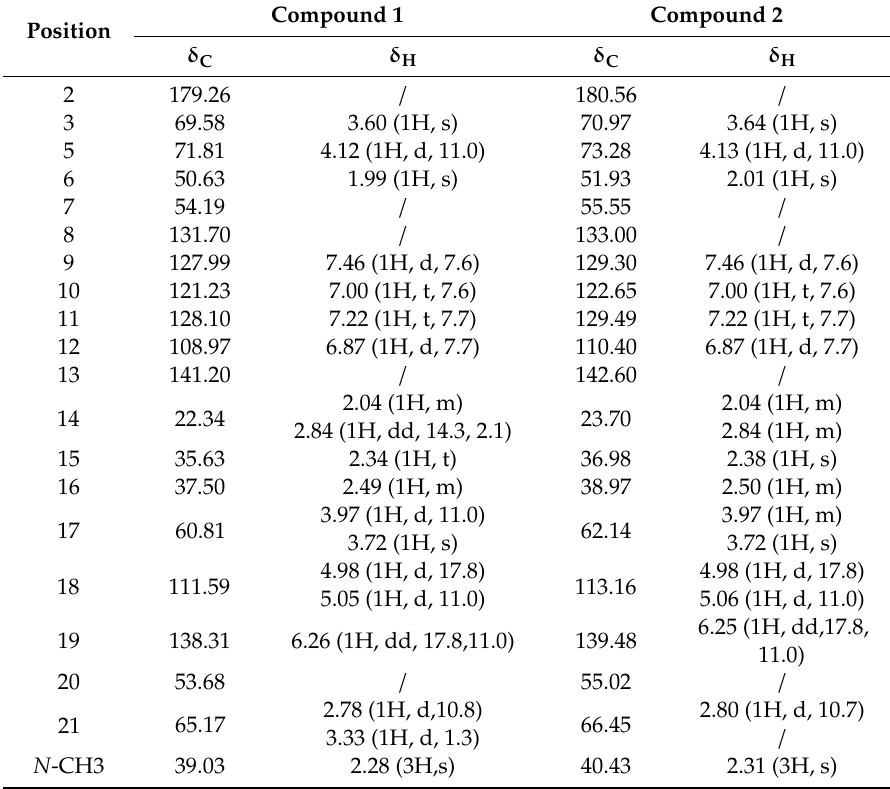
Table 1. 1 H-NMR (400 MHz) and 13 C-NMR (100 MHz) data for Compound 1 and 2 in MeOD ( δ in ppm and J in